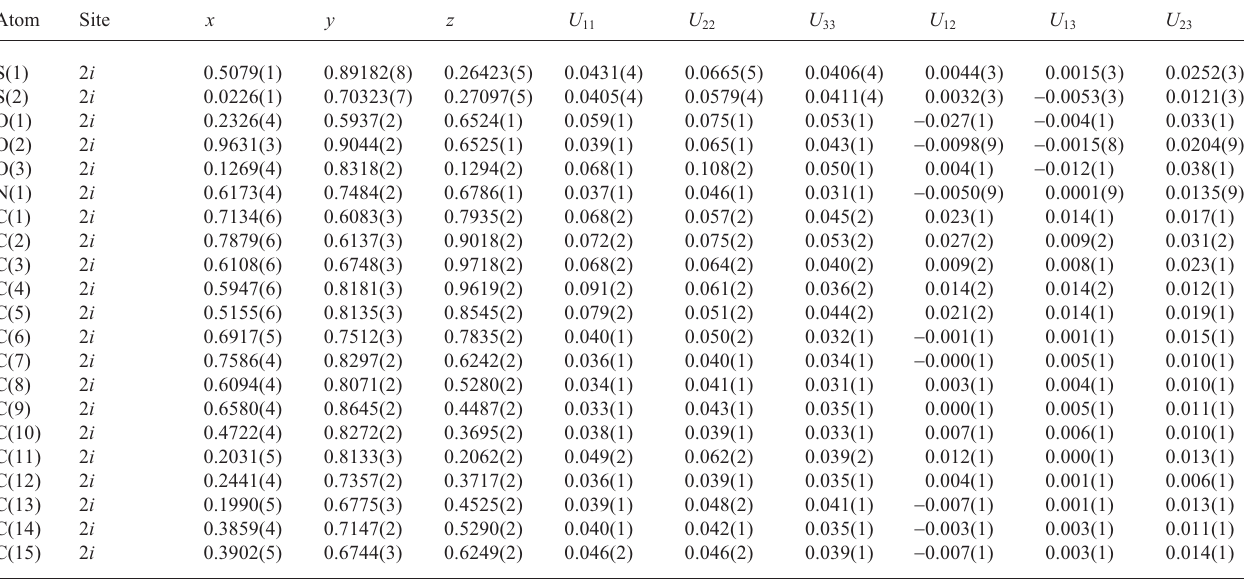
Table 3. Atomic coordinates and displacement parameters (in Å 2 )